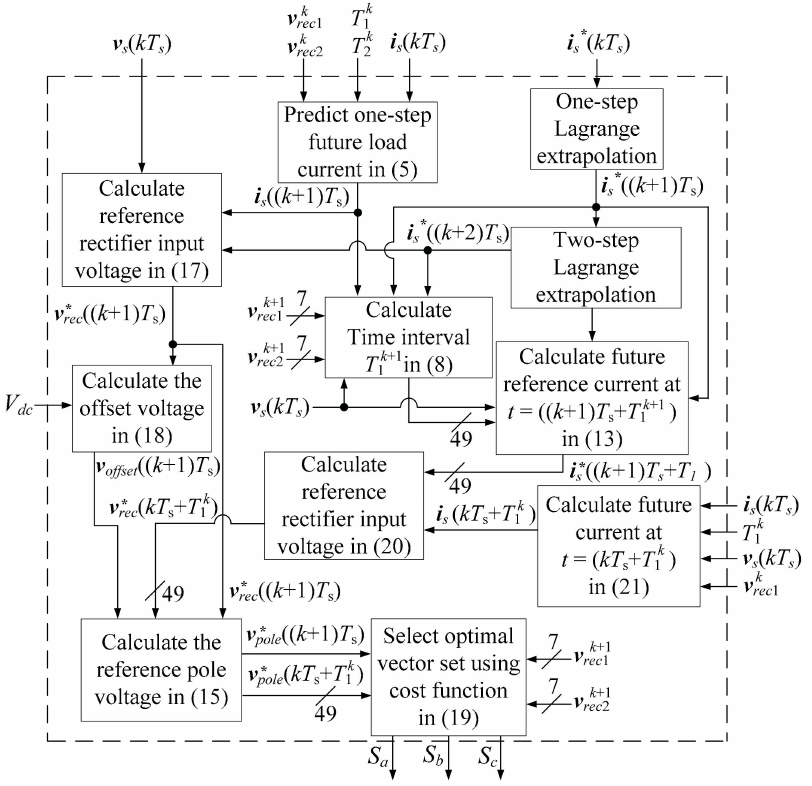
Figure 5. Block diagram of the proposed